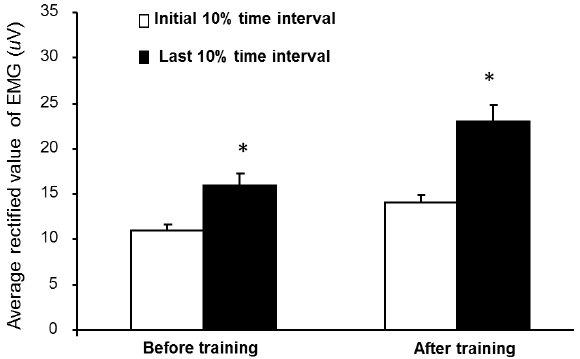
Average rectified value of EMG obtained from the initial and last 10% interval of the time to task failure of the untrained leg (average for the VM, RF and VL muscles) during sustained isometric knee ex- tension at 50% of MVC measured before and after 12 weeks resistance training. * p ≤